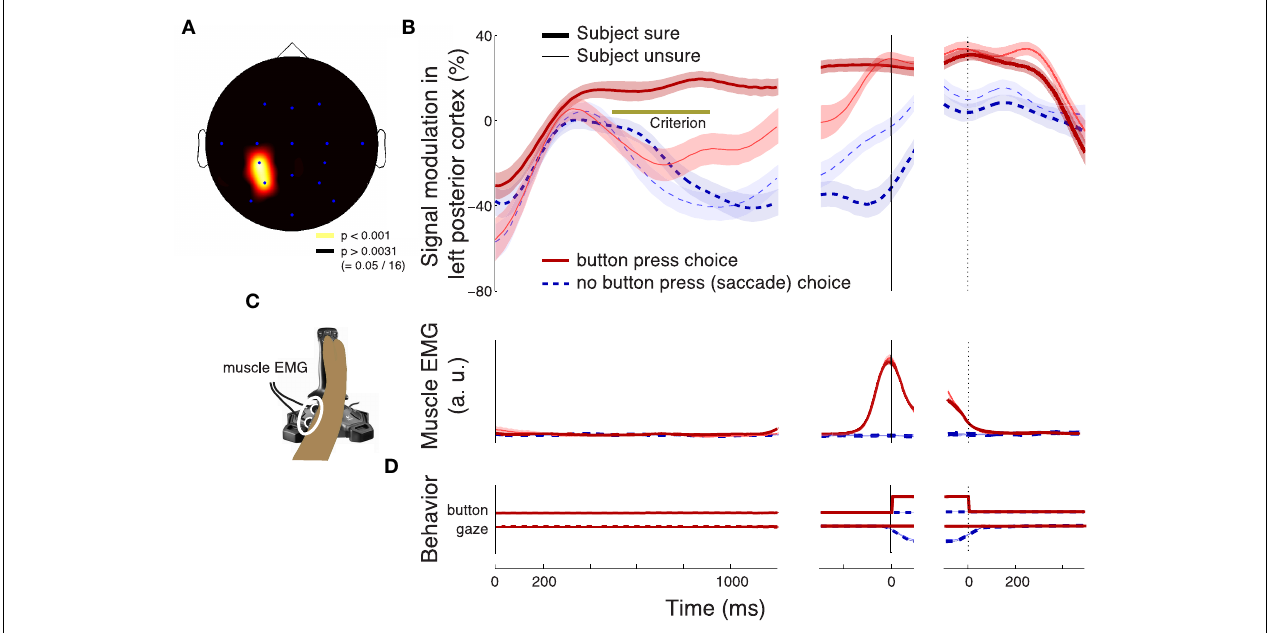
FIGURE 5 | Characterization of the neural effect of the choice confidence. (A) A rendering of the regions that significantly encode the weight associated with the choice confidence in the multiple regression on the alpha-band neural signal, during all button press choices. The neural signal was averaged over the period of significance of the confidence effect (solid bar below the abscissa in Figure 3C ). Regions surrounding channels with significant confidence weights (Bonferroni-corrected, p < 0 . 05 / 16 ) are visualized in hot colors (see inset). The effect is predominantly observed at left posterior channels P3 and CP3. (B) Mean ± SEM alpha desynchronization in left posterior regions (averaged over channels P3 and CP3), as a